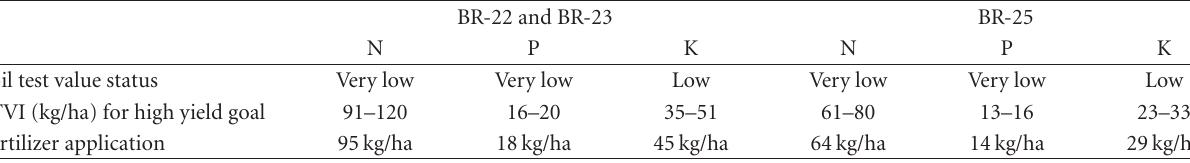
Table 2: Physical, chemical, and physicochemical properties of the soil.